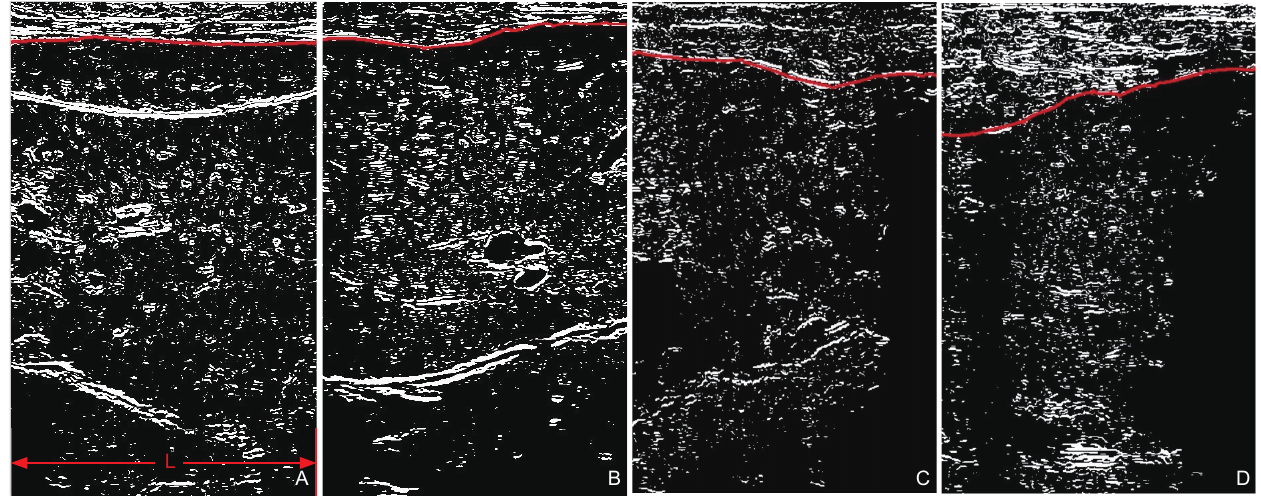
DL B C Figure 3 Contours of hepatic capsule of rabbits with different degrees of cirrhosis. (A) Geometrical parameters of capsule contour of the control group: mean value of angles: 1.95, variance of angles: 0.37, number of segment: 4; (B) Geometrical parameters of capsule contour of the 6th-week group: mean value of angles: 5.55, variance of angles: 12.64, number of segment: 9; (C) Geometrical parameters of capsule contour of the 12th-week group: mean value of angles: 5.56, variance of angles: 17.15, number of segment: 16; (D) Geometrical parameters of capsule contour of the 18th-week group: mean value of angles: 9.13, variance of angles: 29.92, number of segment: 17. (The curves in red refer to the extracted contours of the hepatic capsule, and L refers to the total width of the sectional image).